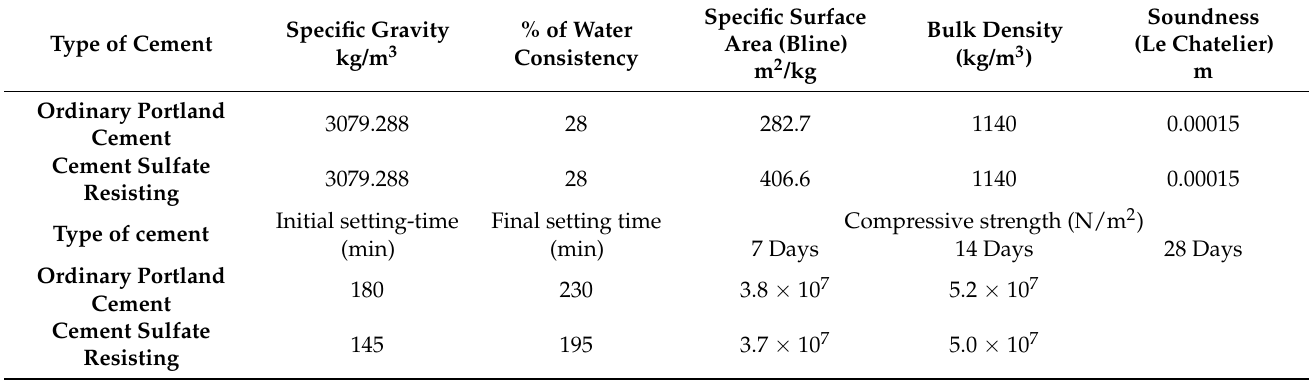
Table 2. The properties of cement types.